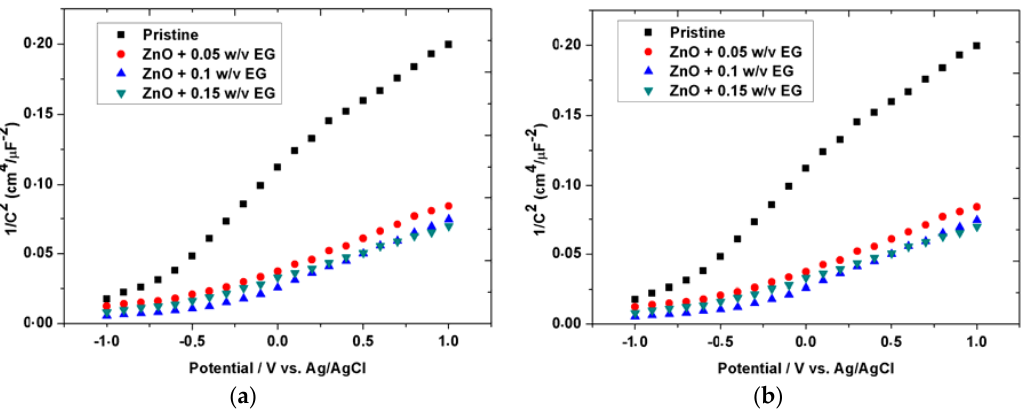
Figure 6. ( a ) & ( b ) Mott-Schottky plots of the ZNRs grown on Au with different amount of EG at 5